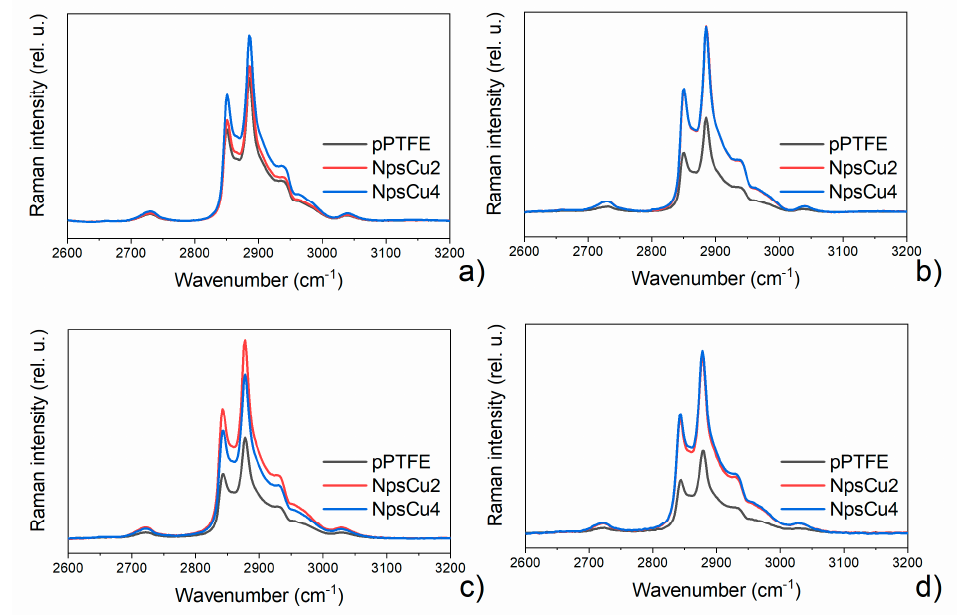
Figure 7. Averaged spectra (baseline corrected) for ( a ) 1 mg/mL, ( b ) 0.5 mg /mL, ( c ) 0.25 mg/mL and ( d ) 0.125 mg/mL deposited concentration of DPPC in the form of liposome suspension.